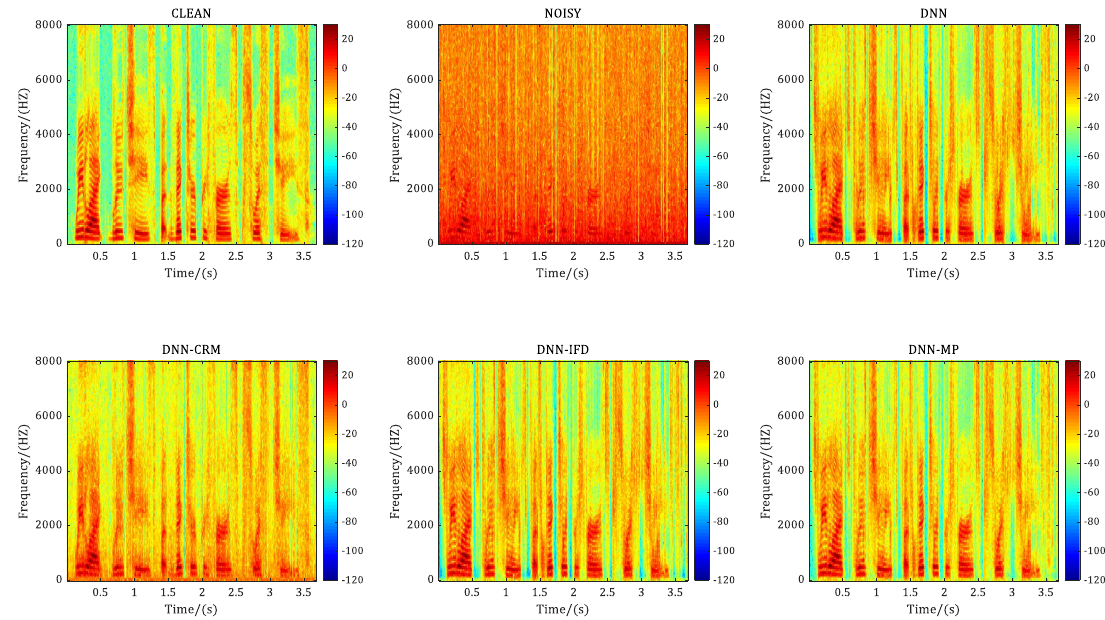
Figure 8. Performance comparison in terms of spectrogram for factory2 noise at − 5 dB SNR level.